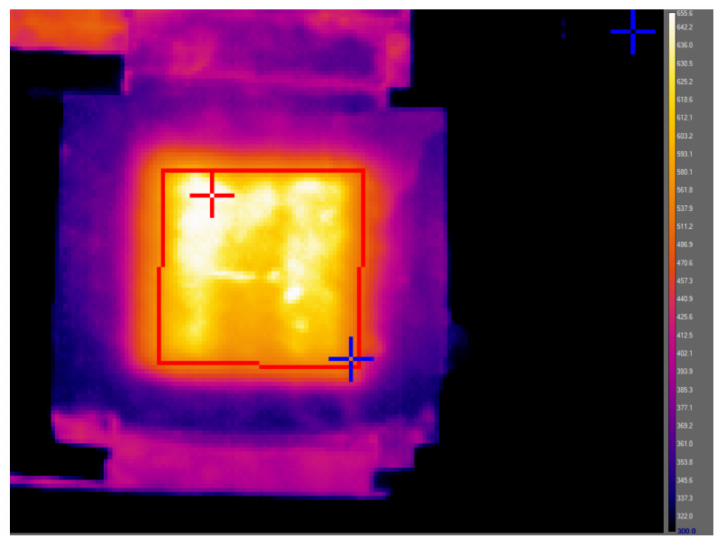
Figure 19. Thermal image of the ODS mock-up by the IR camera. The coolant inlet is on the bottom of the figure, the helium channels being oriented vertically in this picture. The red cross indicates the position of the maximum temperature (656 ◦ C) and the blue cross the lowest temperature (504 ◦ C) the averaged value being around 612 ◦ C.